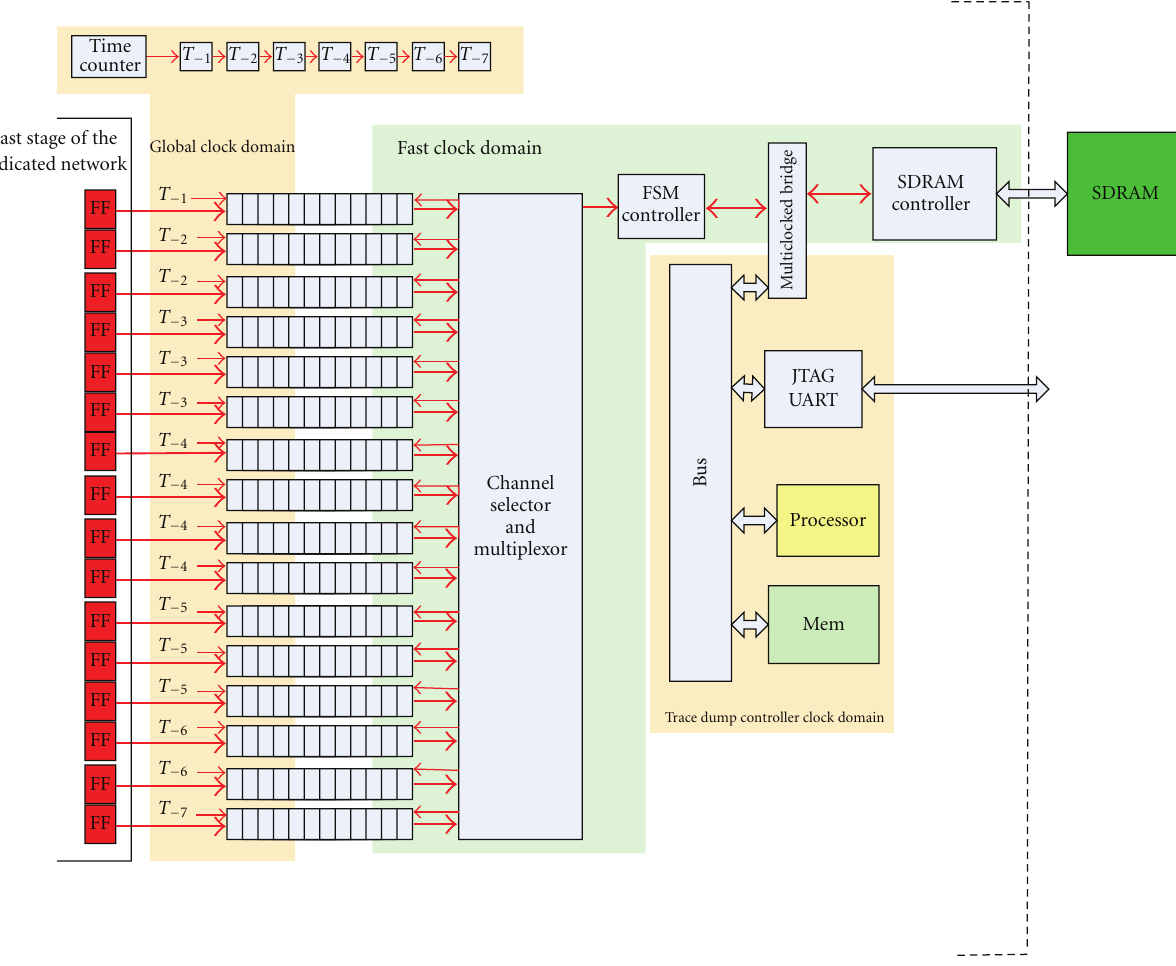
Figure 16: Architecture of the tracing